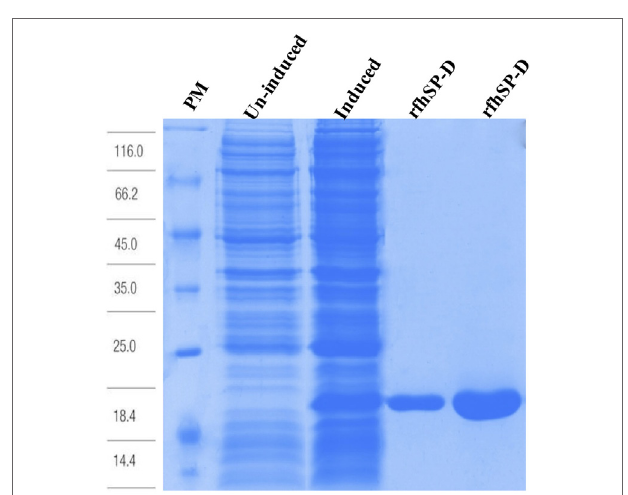
FigUre 2 | Recombinant fragment of human SP-D (rfhSP-D) expression and purification. Escherichia coli BL21 ( λ DE3) pLysS containing pUK-D1 was induced with IPTG. The expressed bacterial cells show rfhSP-D over-expression at ~20 kDa as compared to un-induced cells. The insoluble inclusion bodies were refolded and affinity purified on maltose-agarose. The peak fractions shown here appeared homogenous on a 12% SDS-PAGE.